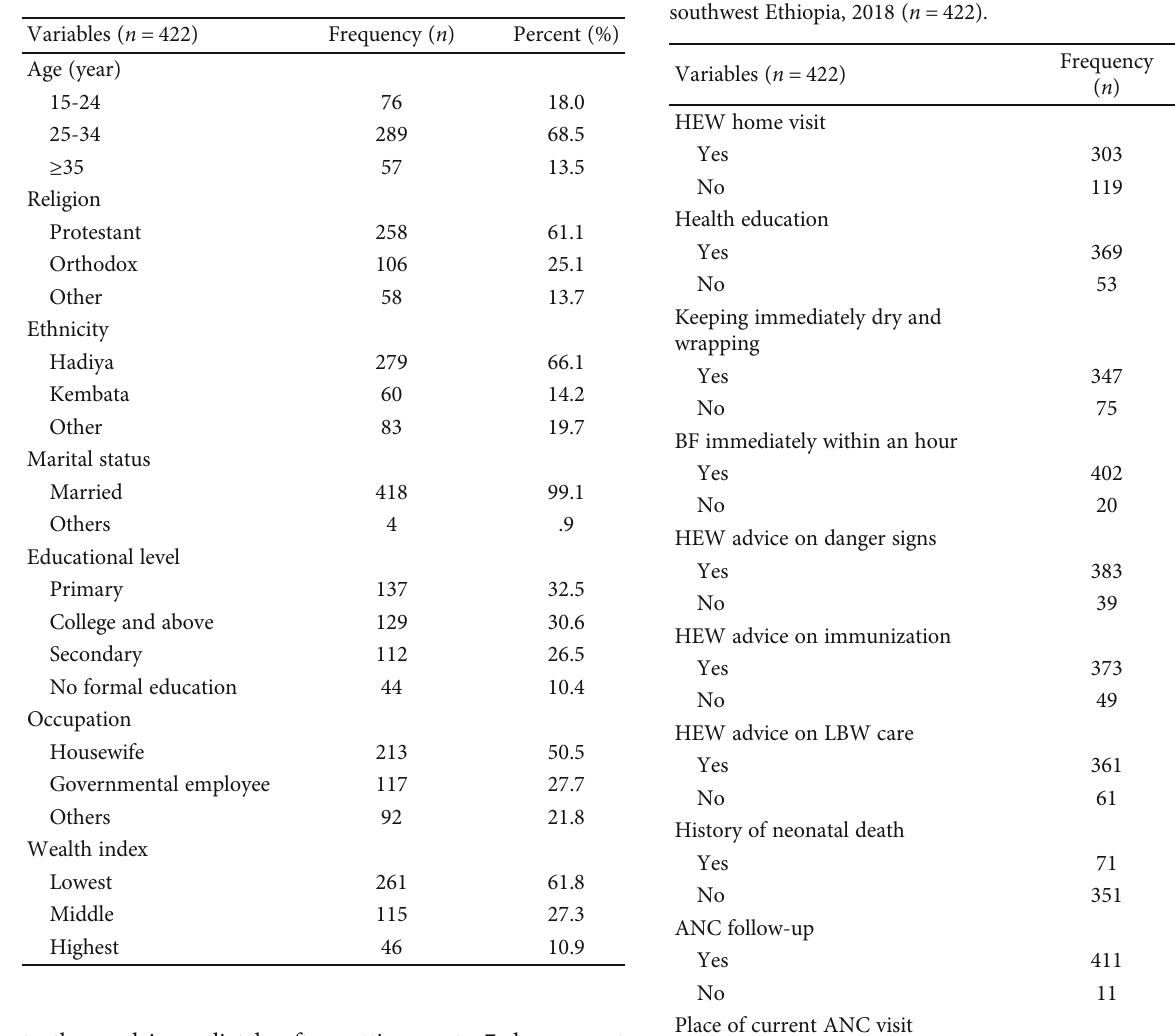
Table 1: Sociodemographic variables of mothers with babies of one- month-old in Hossana town, southwest Ethiopia, 2018 ( n = 422 ).